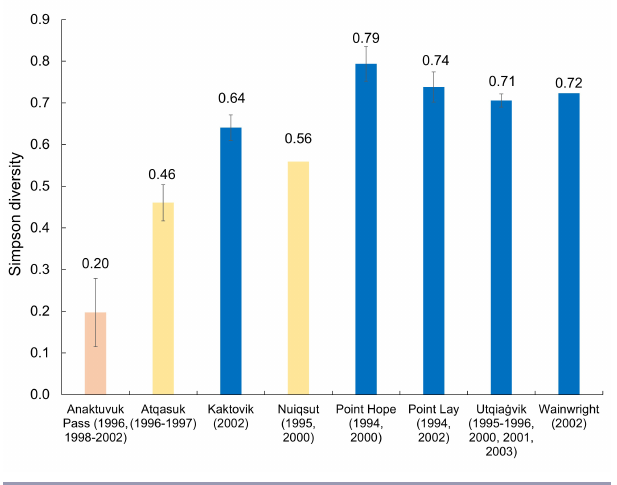
Fig. 4 . Average annual Simpson’s Diversity Index for subsistence harvest species in North Slope communities. Survey years are enclosed in parentheses. Blue bars represent coastal communities, yellow bars communities near the coast, and orange bars inland communities. Error bars represent standard deviations. Source: Bacon et al. 2009.